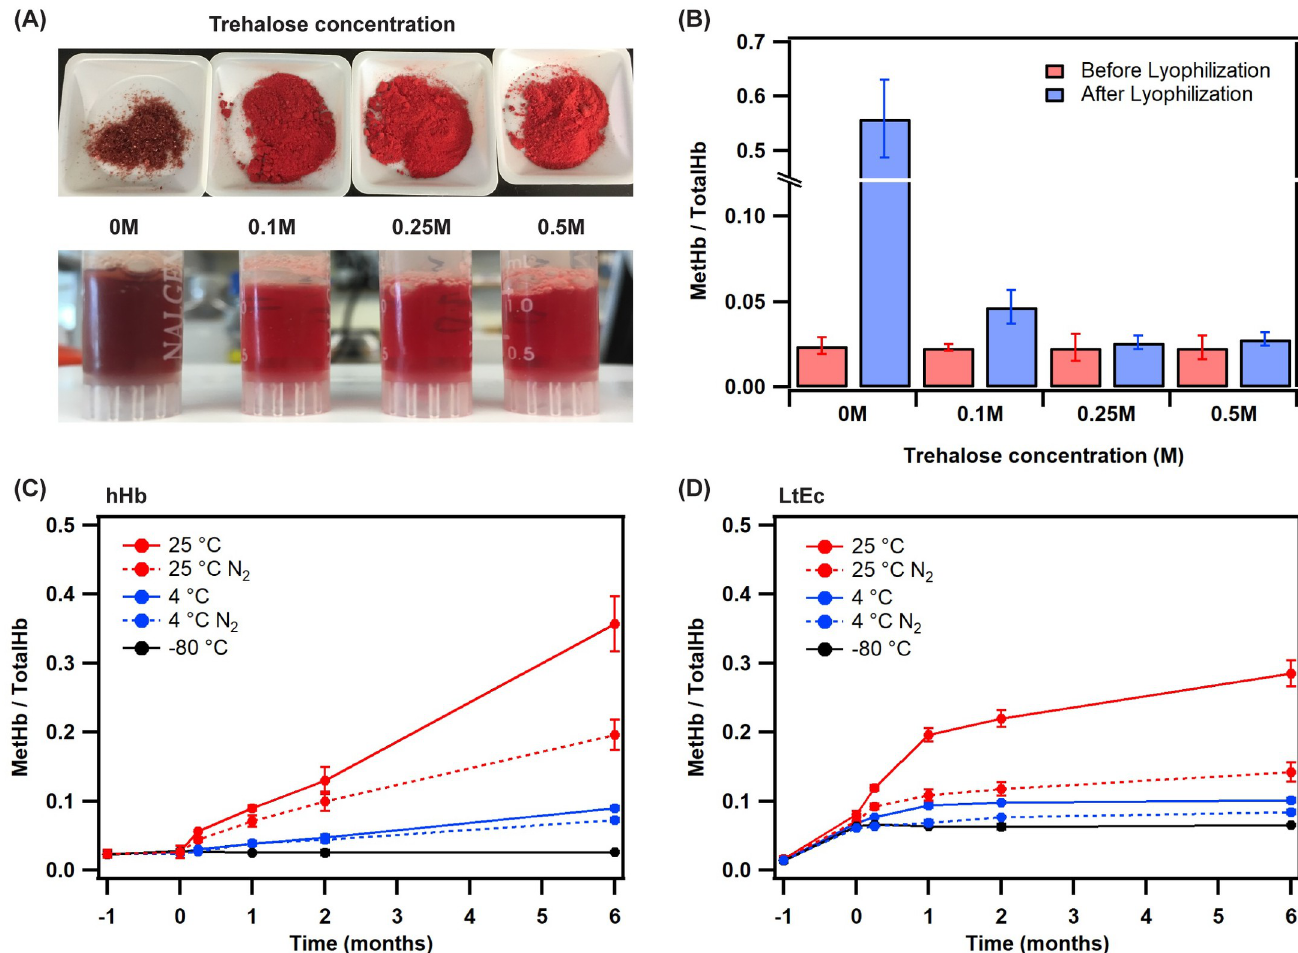
Fig 1. (A) Images of hHb after lyophilization in powdered and rehydrated form as a function of trehalose concentration. (B) MetHb formation in hHb samples before and after lyophilization as a function of trehalose concentration. (C-D) MetHb formation for hHb and LtEc samples respectively over 6 months. Conditions tested were storage at 25˚C, 4˚C and -80˚C in the presence and absence of a N 2 environment (i.e., oxygenated/deoxygenated conditions). Error bars indicate the standard deviation from the